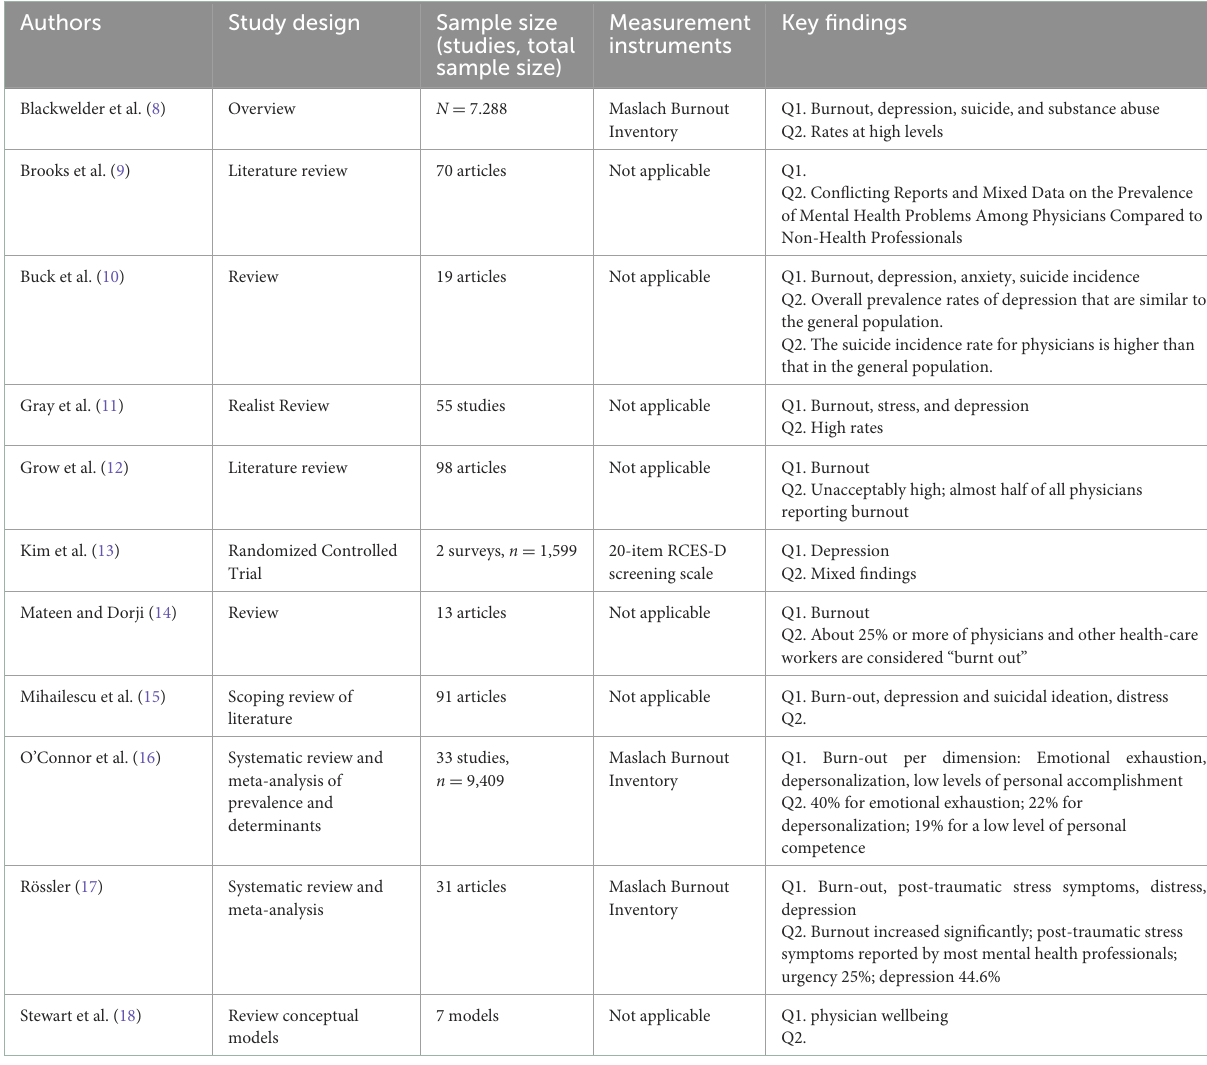
TABLE 2A Overview of the characteristics of the studies answering Q1 and